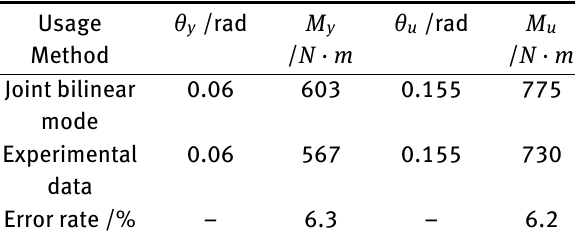
Table 3: Bilinear model and experimental error analysis Table 4: Material properties of experimental and simulation